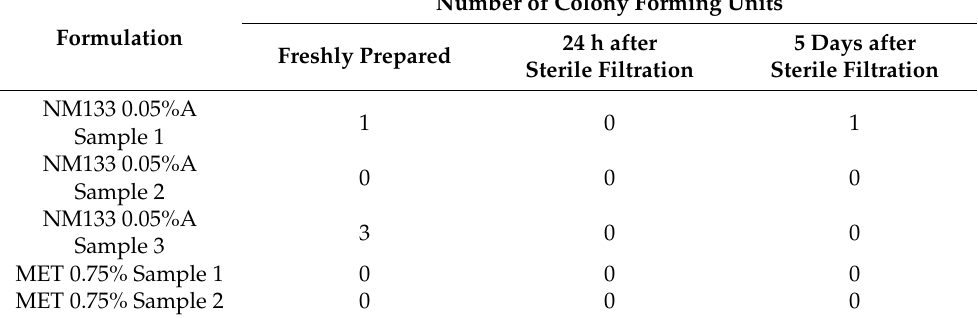
Table 7. Results of British Pharmacopoeia Sterility Testing on Sterile Filtered NM133 0.05%A and the NM133